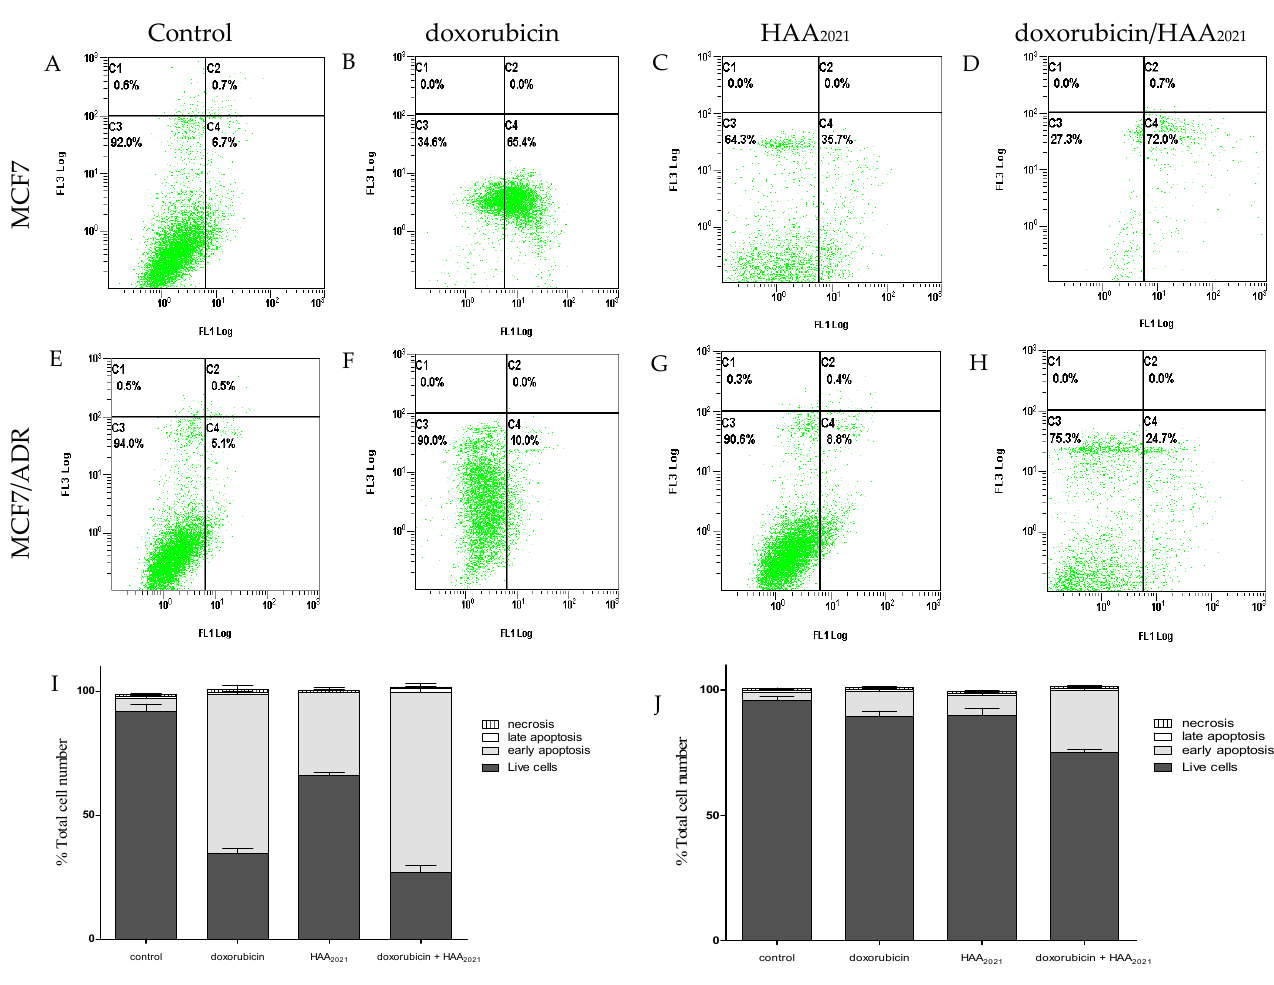
Figure 3. Induction of apoptosis in MCF7 and MCF7/ADR cells treated (72 h) with ( A , E ) vehicle control, ( B , F ) doxorubicin (1 μ M), ( C , G ) HAA 2021 (0.25 μ M), and ( D , H ) doxorubicin/HAA 2021 combination (1 and 0.25 μ M, respectively). ( I , J ) Stacked histograms of the effect of doxorubicin and HAA 2021 on MCF7 and MCF7/ADR cells. Results were expressed as mean ± SD, n = 3 × 3 independent